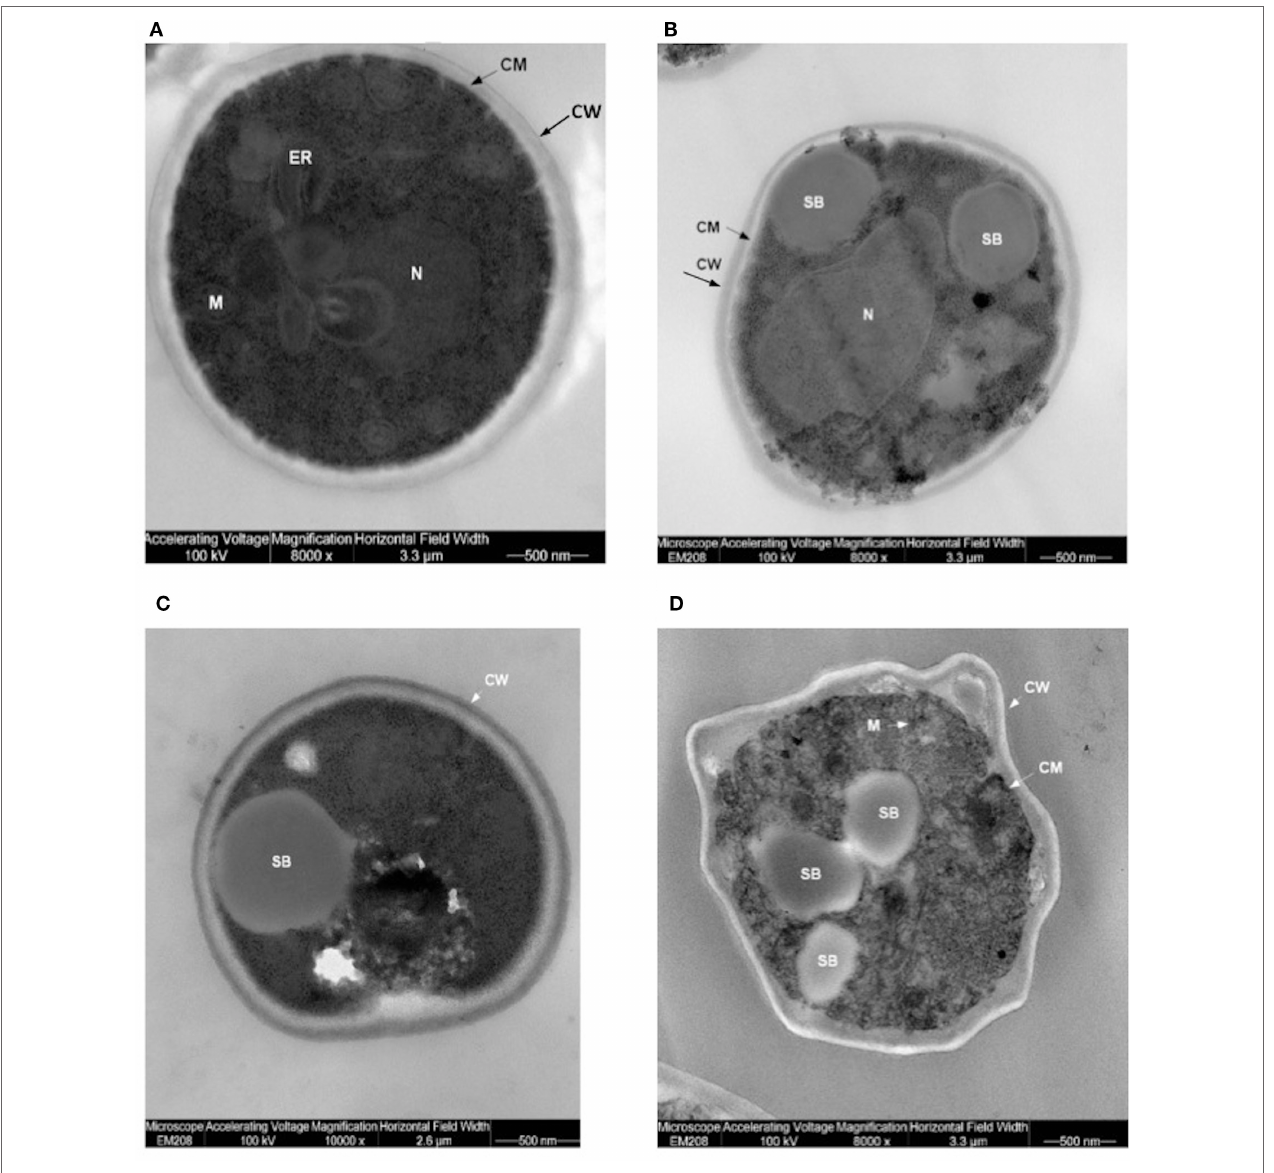
FigUre 4 | Trasmission electron microscopy (TEM) of aged (4 weeks old) translocants compared to the wild type (WT) strain: (a) WT San1, (B) TNT10, (c) TNT 10/ P53, and (D) TNT 10/H273. N, nucleus; SB, spherical body; CW, cell wall; CM, cell membrane; M, mitochondria; ER, endoplasmic